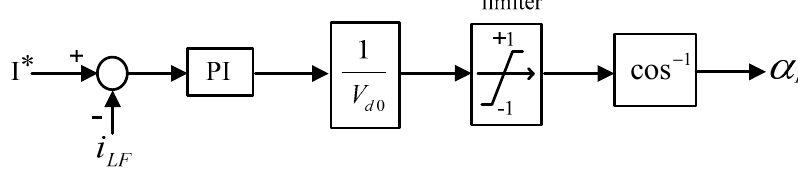
Figure 5. Current limiter of LFAC.